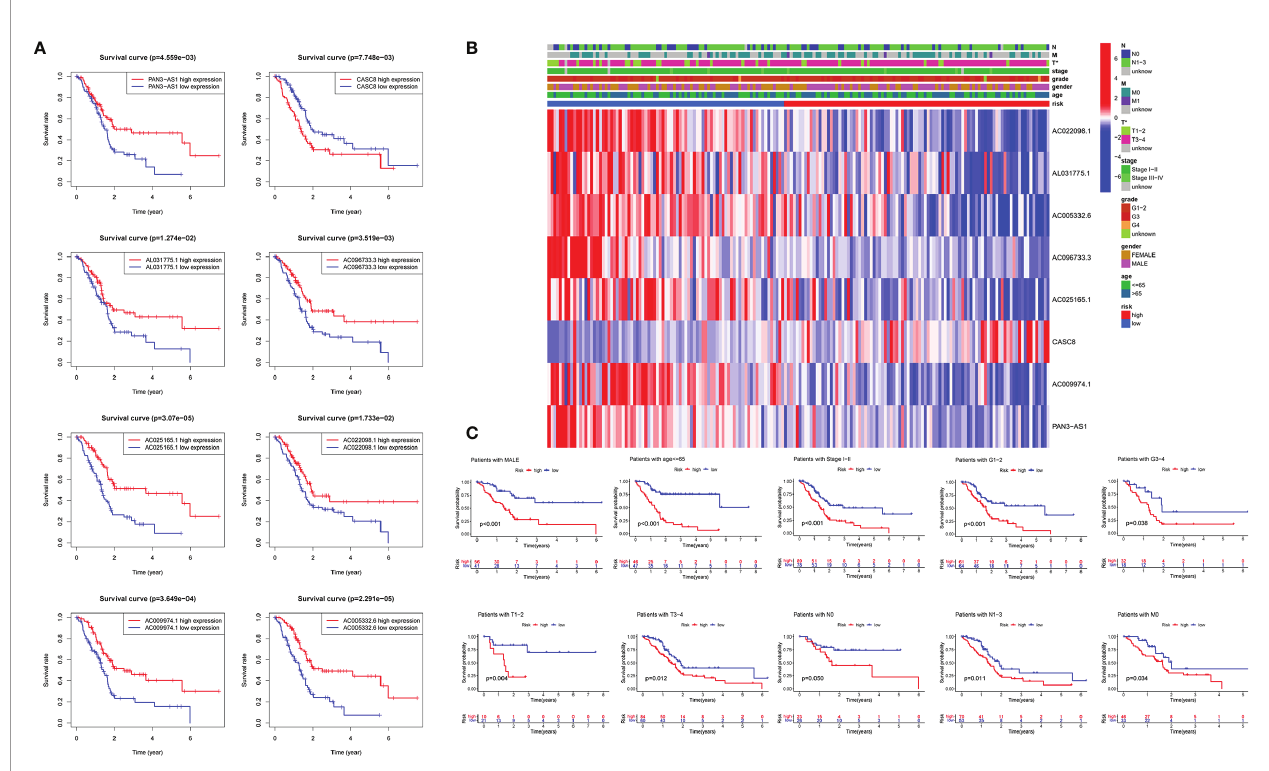
FIGURE 3 | Relationships between m5C-related lncRNAs and clinical pathological parameters. (A) Eight survival curves based on the m5C-related lncRNAs expression. (B) Heatmap displayed the clinical characteristics and differences in the high- and low-risk group calculated by m5C-related lncRNA risk scores. (C) Survival analysis in subgroups including gender, age and tumor